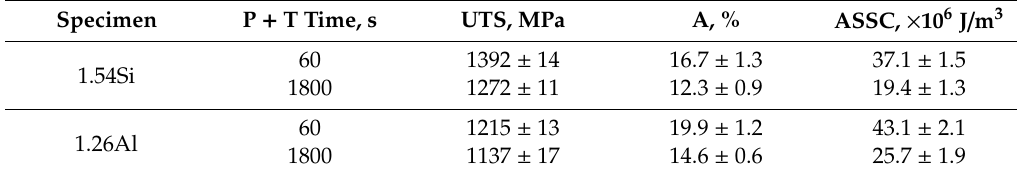
Table 1. Tensile properties of the investigated